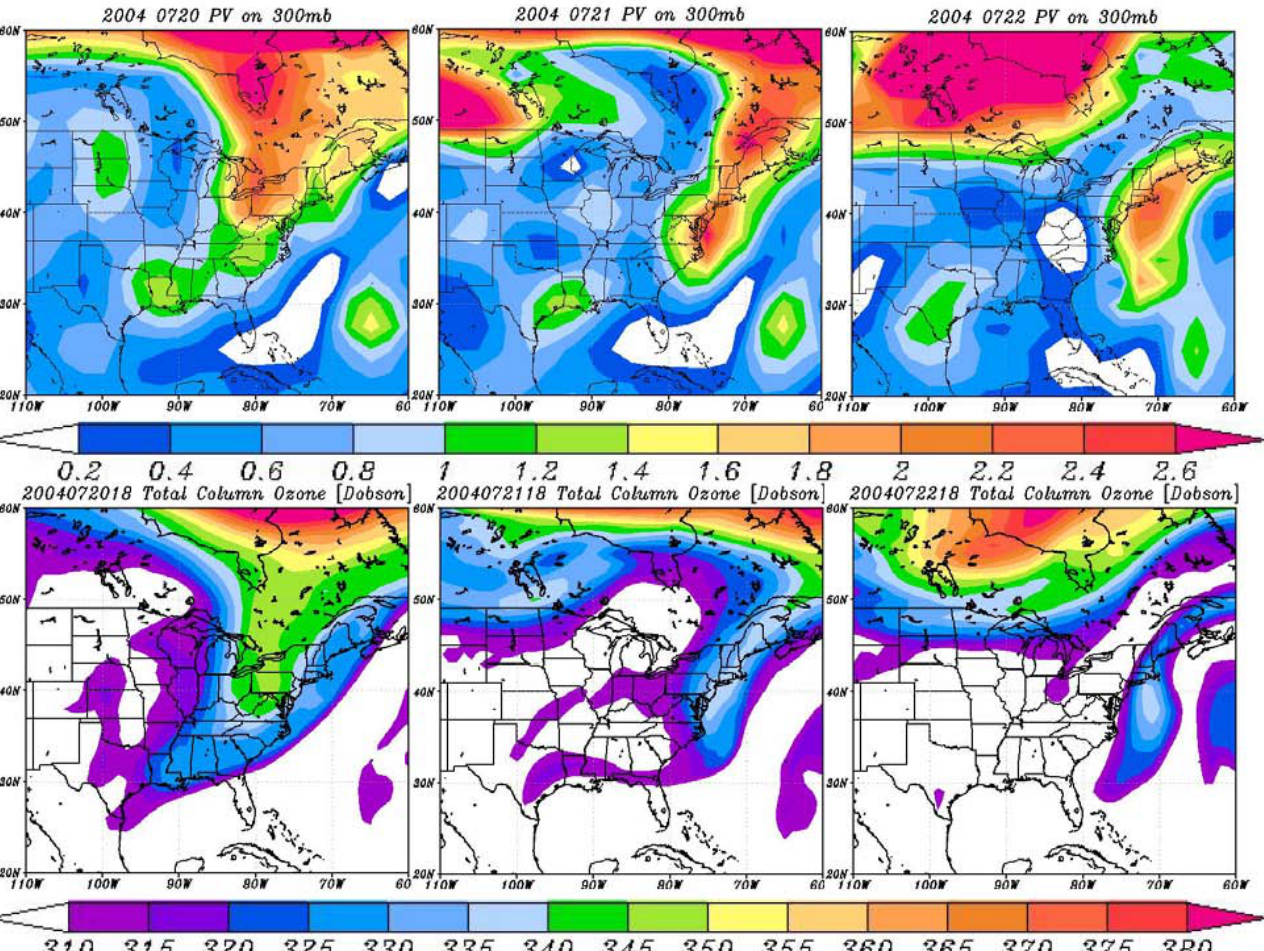
Figure 13. (Top) The NCEP 2.5° × 2.5° Potential Vorticity (PV) at 1200 UTC at 300 mb on 20–22 July 2004. The shaded interval is 0.2 PV. (Bottom) NCEP 1° × 1° Total column ozone (Dobson) on 20–22 July 2004. The interval is 5 Dobson